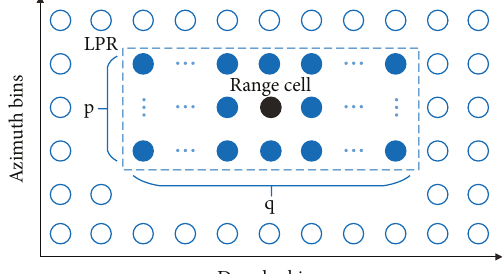
Figure 14: Size of the LPR.